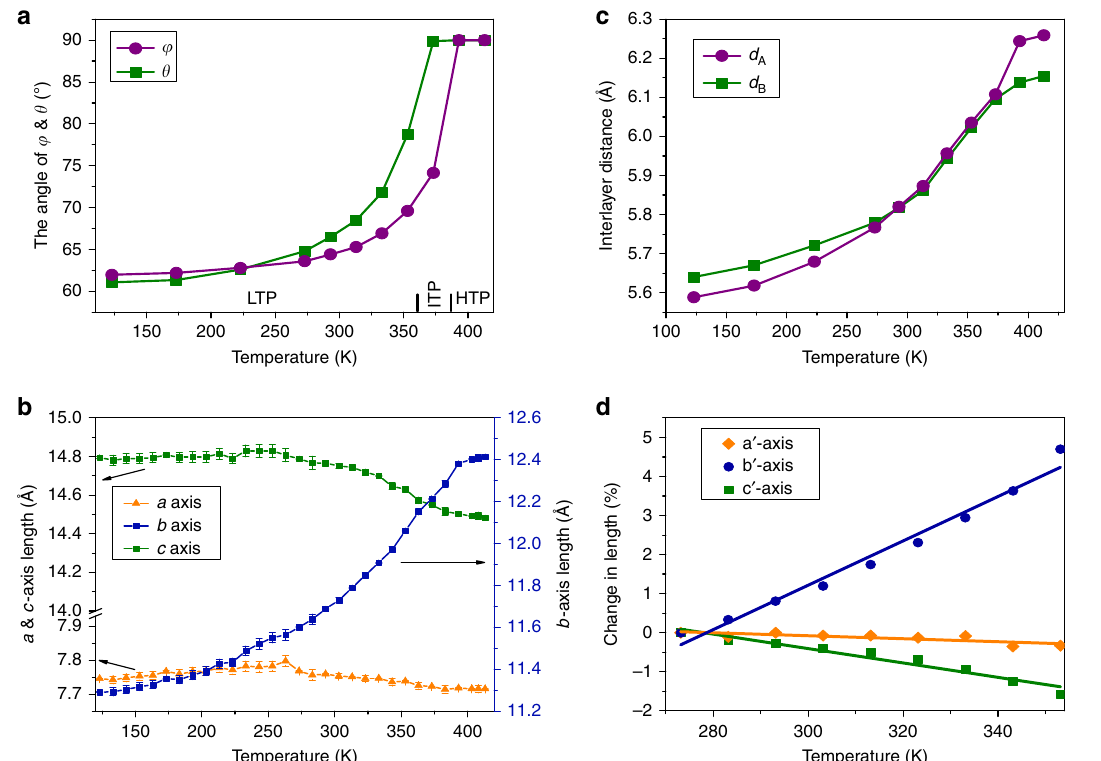
Fig. 2 Temperature-dependent unit-cell parameters of 1 . a The dihedral angles between the Himd + molecular planes and the crystallographic (010) face. As the temperature increases, both φ and θ gradually increase and fi nally reach 90° at 393 K. b The interlayer distances between CuCl 4 2 − dianions separated by the Himd + cations in layers A ( d A ) and B ( d B ). c The unit-cell length of 1 . Upon heating, the b -axis length increases monotonically in the temperature range of 123 to 393 K, whereas the a -axis and c -axis lengths increase slightly from 123 to 263 K, and then decrease signi fi cantly from 273 to 393 K. d The anisotropic thermal expansion of the material along the principal axes ( a ′ , b ′ , and c ′ ) obtained from PASCal in the temperature range from 273